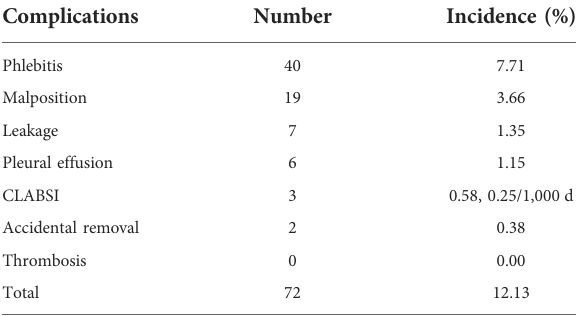
TABLE 2 Incidence of PICC-associated complications in ELBW/VLBW infants ( n =519).